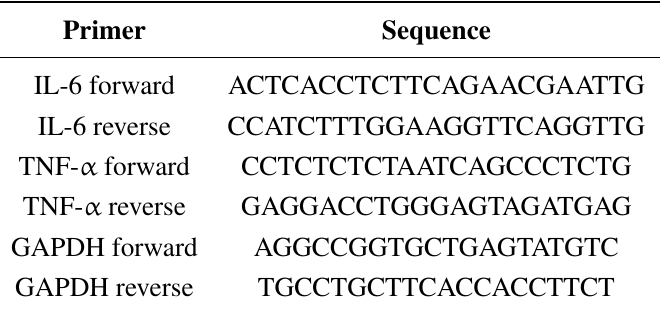
Table 2. Primer for polymerase chain